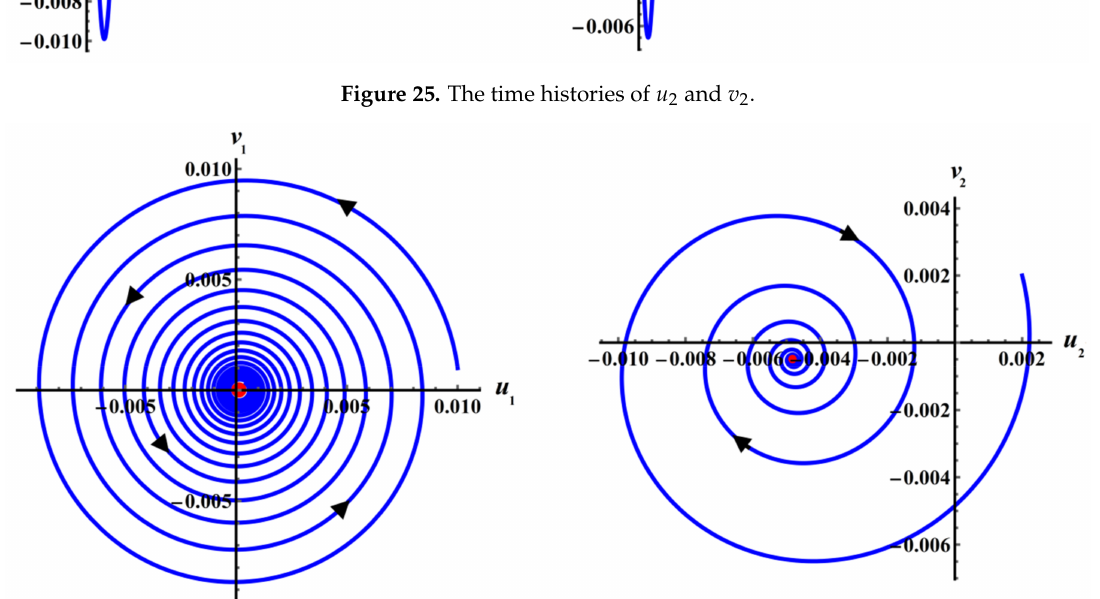
Figure 26. The projection of the trajectories of the modified amplitudes in the plans u 1 v 1 and u 2 v 2